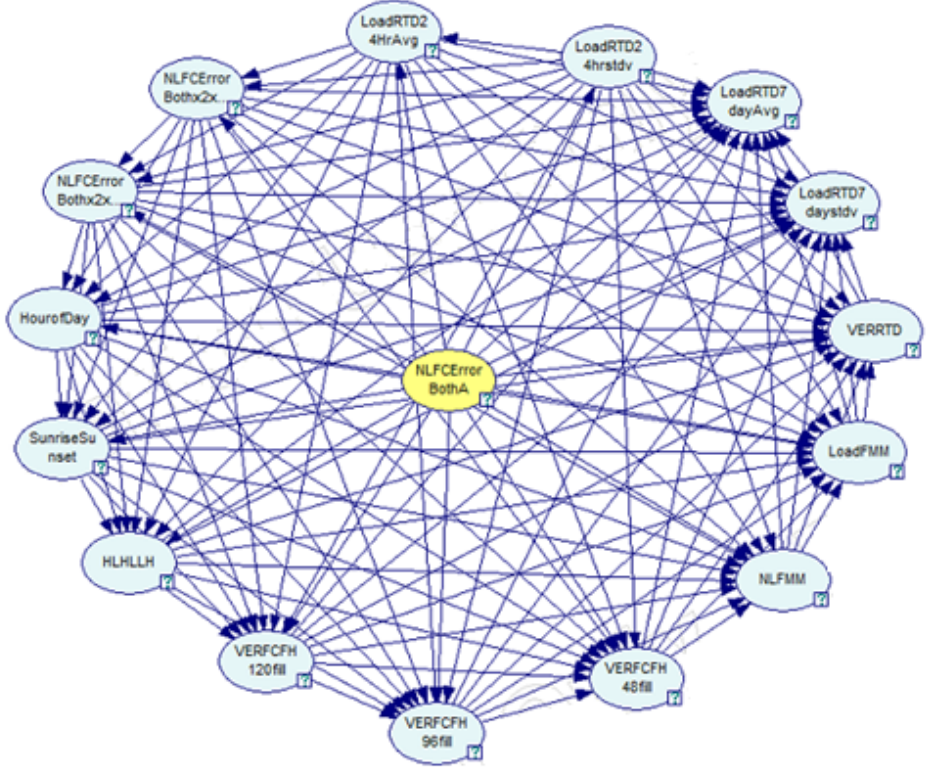
Figure 3. Best RA Model equivalent BN.